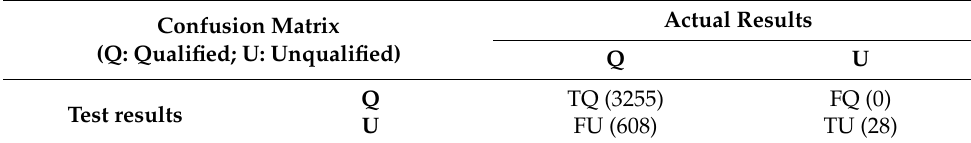
Table 2. Cross-relations between test and actual